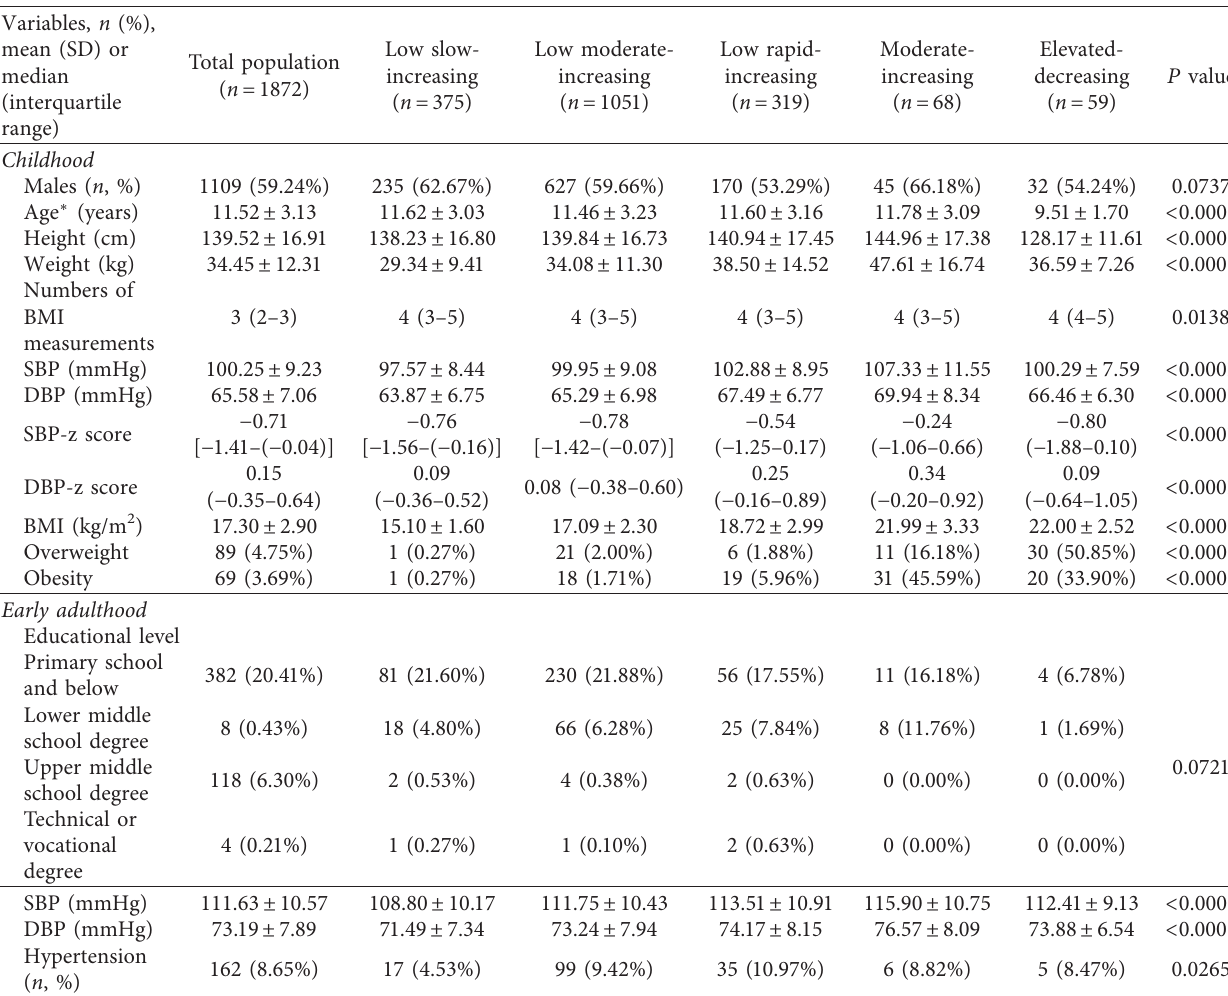
Table 2: Characteristics of study participants in childhood and early adulthood.